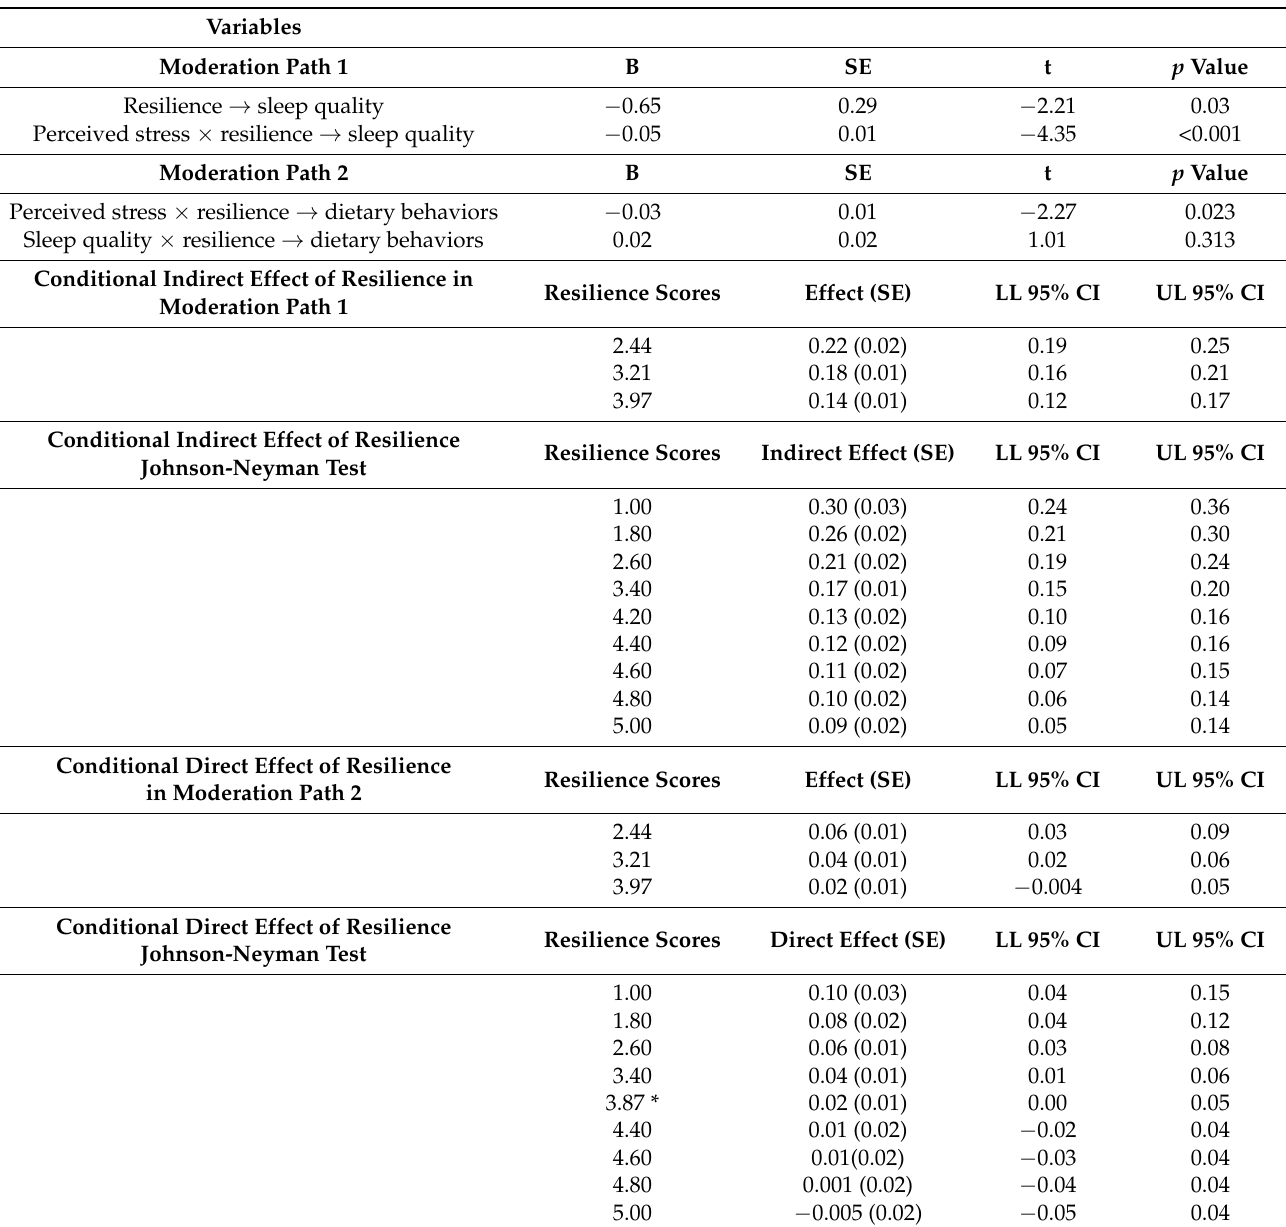
Table 7. Model 1 moderation analysis.